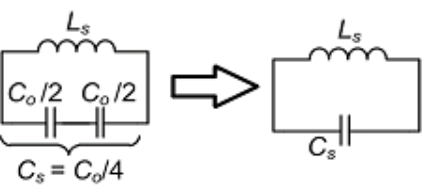
Figure 9. SRR equivalent circuit model.